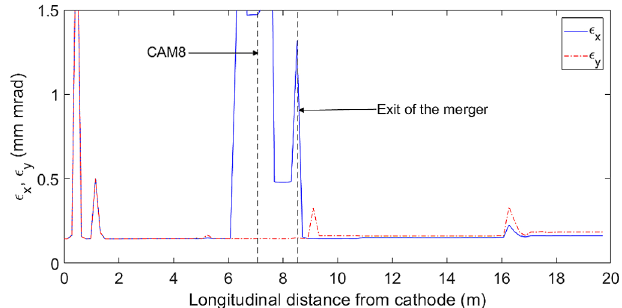
FIG. 8. The horizontal (solid line) and the vertical (dotted- dashed line) emittances from the electron gun up to the exit of the main linac cavities for the Gaussian with σ ¼ 3 . 3 ps core with ¼ 100 ps longitudinal distribution. longitudinal tail t cutoff